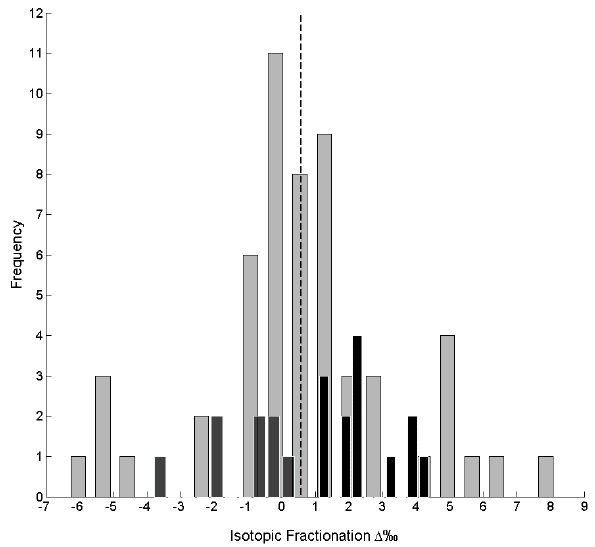
Fig. 3. Estimates of apparent fractionation associated with soil mi- crobial respiration determined by different experimental approaches (grey bars: from C 3 plants; dark grey bars: Rayleigh distillation methods, black bars: C 4 plants). The dashed line is the mean of all estimates. Data sources: Werth and Kuzyakov, 2010; Wynn et al., 2005, 2006; Diochon and Kellman,